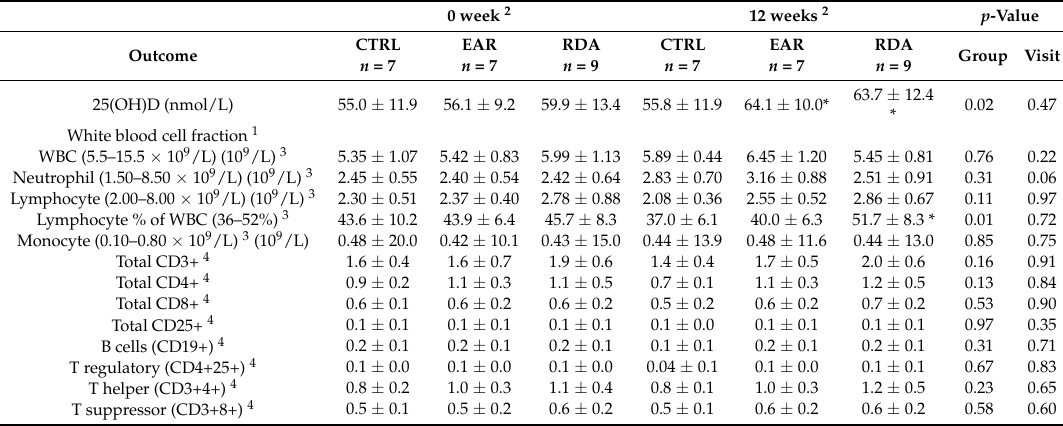
Table 4. Mononuclear cell phenotypes in 6–8 years old subset of 12 weeks trial.